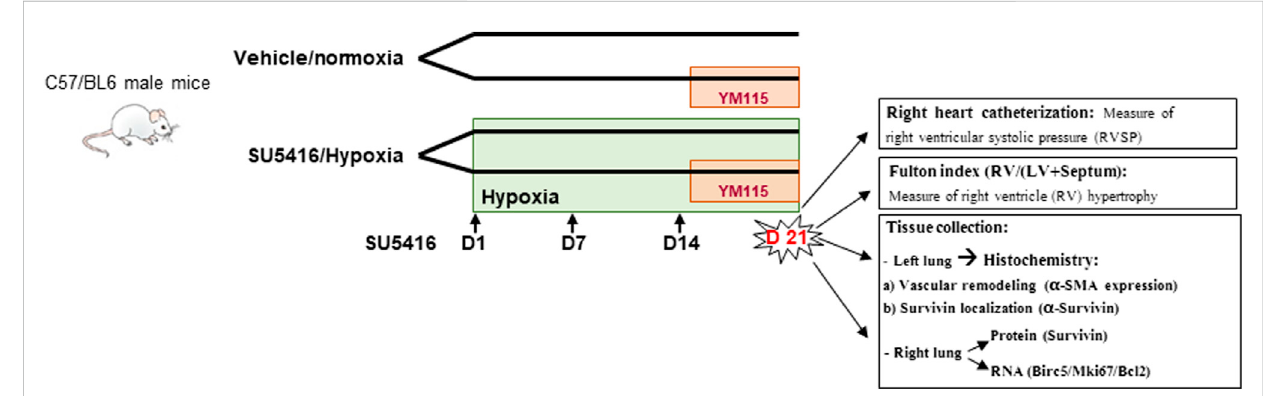
FIGURE 1 Schematic of the experimental design. Vehicle: DMSO; SU5416: Sugen; YM155: Survivin